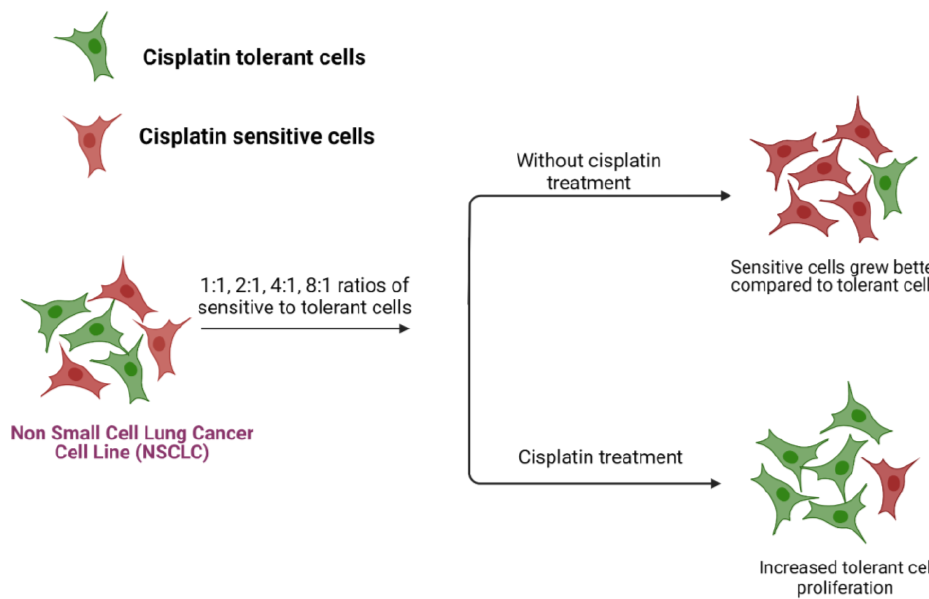
Figure 4. Behavior of cisplatin-sensitive and tolerant NSCLC cells in the 2D co-culture.